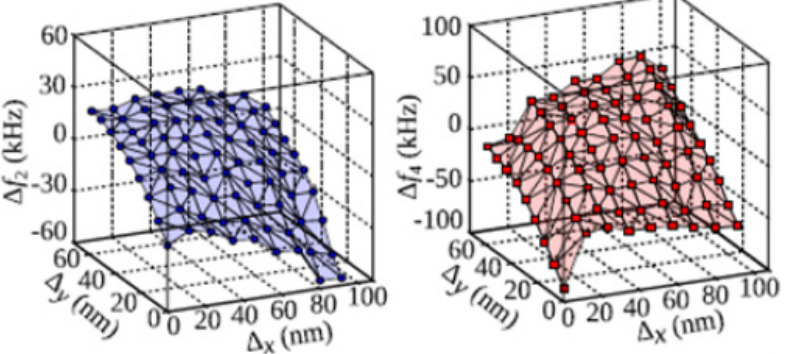
Figure 8. The relationship between the quasi-periodic frequency shift and 2D displacement (adapted with permission from [63] © The Optical